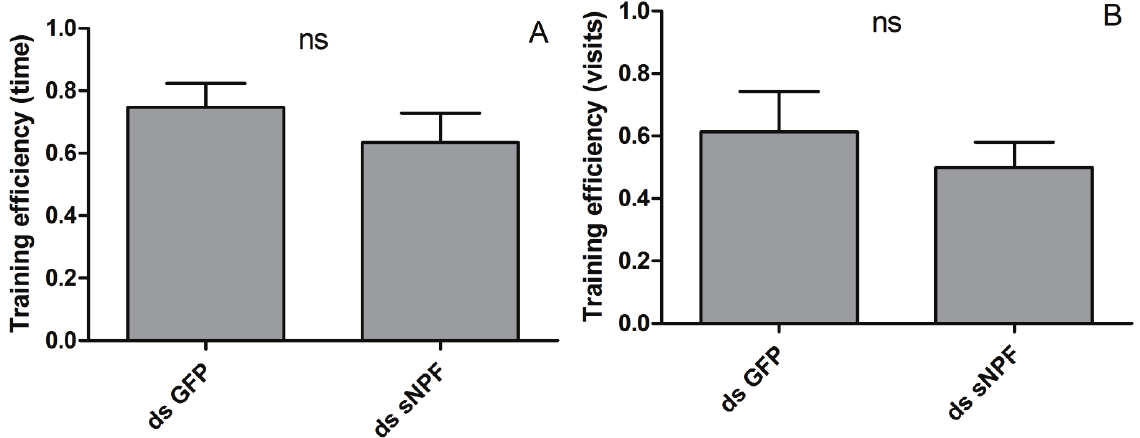
Figure 5. RNAi mediated knockdown of the mRNA encoding the Schgr-sNPF precursor does not significantly influence the efficiency of visual learning. Training efficiencies were calculated according to the time spent in each box ( A ) or the total number of visits to each box ( B ) Data represent average ± SEM ( n = 6). Results were analyzed using the Mann-Whitney U test. ns: no significant